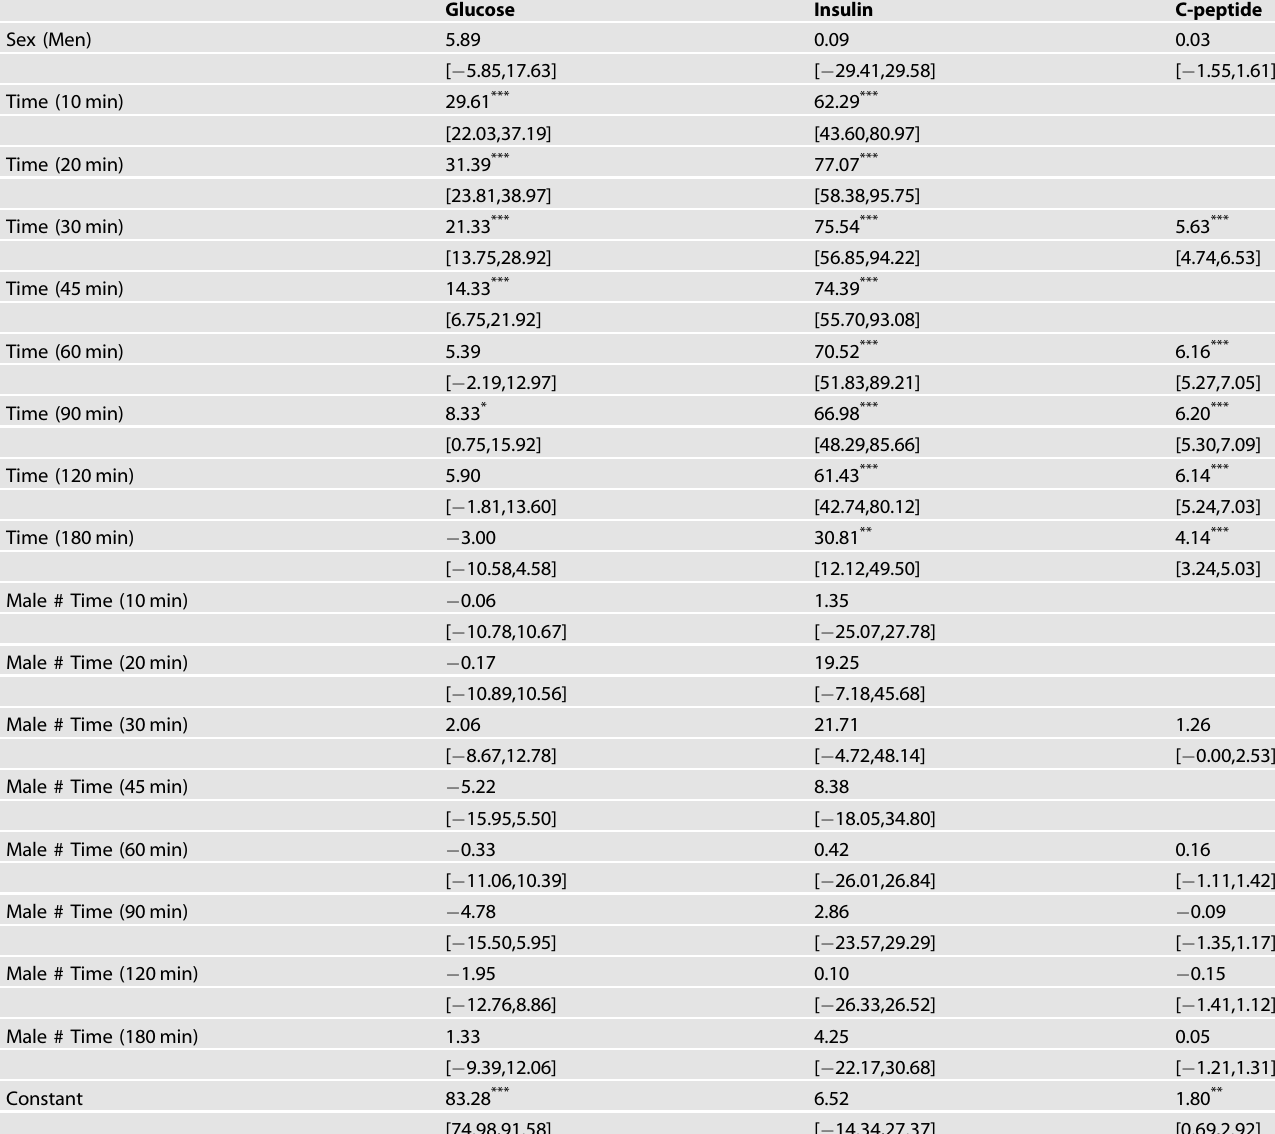
Table 3. Linear mixed models showing the effect of sex, time, and sex # time interaction on post-prandial glucose homeostasis. Glucose Insulin